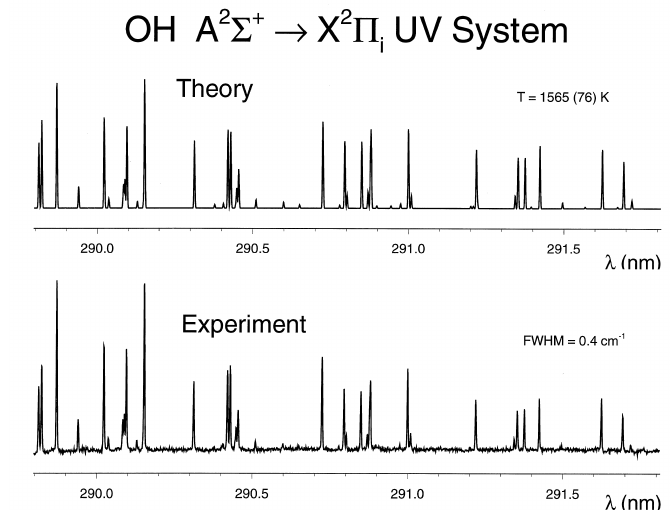
Figure 8. Comparisons of measured and recorded laser induced fluorescence spectra [108].